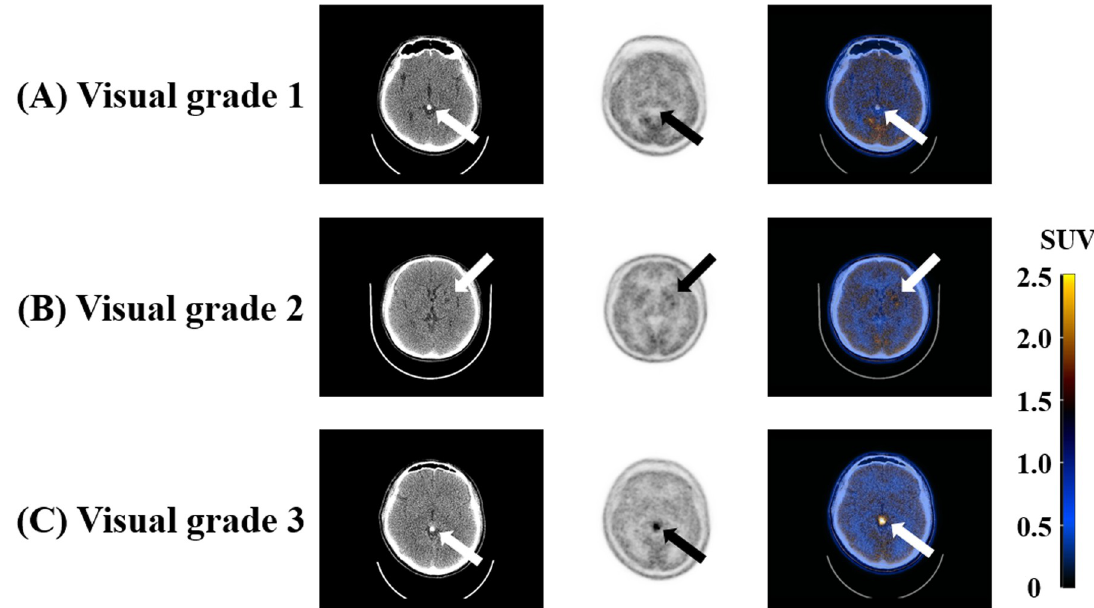
Fig 1. Examples of the three-grade visual scoring system for IG. (A) A case of visual grade 1 was a 24-year-old male patient with pineal germinoma and was post-Tx MET PET/CT images. Tumor size was 9 mm, and post-Tx SUV max and T/N ratio were 1.52 and 1.10, respectively. The MET uptake of tumor was indistinguishable from that of normal brain tissue. (B) A case of visual grade 2 was a 13-year-old male patient with left basal ganglia germinoma and was post-Tx MET PET/CT images. Tumor size was 12 mm, and post-Tx SUV max and T/N ratio were 2.26 and 1.85, respectively. The MET uptake of tumor showed slightly higher MET uptake than that of surrounding normal brain tissue. (C) A case of visual grade 3 was 23-year-old male patient with pineal germinoma and was pre-Tx MET PET/CT images. Tumor size was 19 mm, and pre-Tx SUV max and T/N ratio were 3.97 and 3.45, respectively. The MET uptake of tumor was distinctly higher than that of surrounding normal brain tissue. IG, intracranial germinoma; post-Tx, post-treatment; MET, C-11 methionine; PET, positron emission tomography; CT, computed tomography; SUV max , maximum standardized uptake value; T/N, tumor-to-normal tissue; pre-Tx, pre-treatment; SUV, standardized uptake